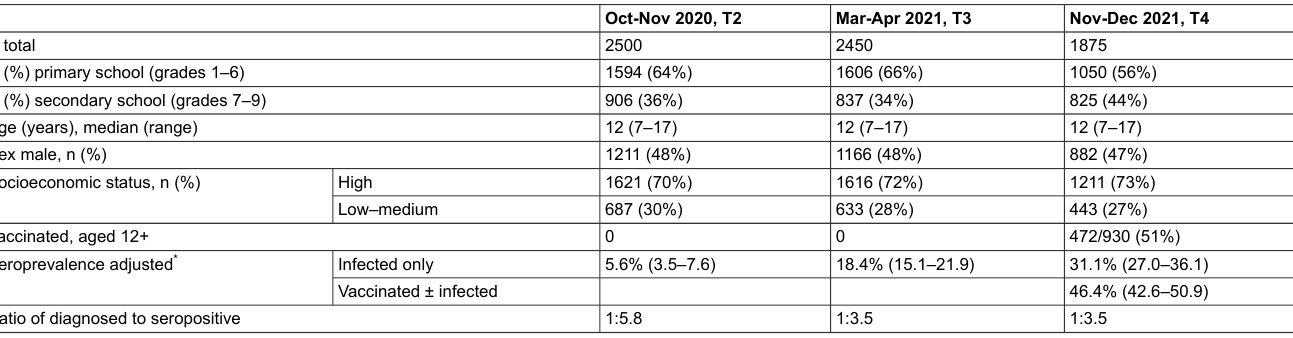
Table 1: Characteristics of study participants over